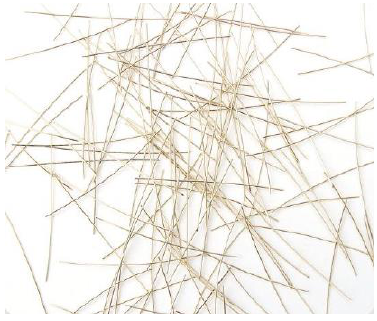
Figure 2. Steel fibers. Table 1. Properties of steel fibers. Table 1. Properties of steel fibers.